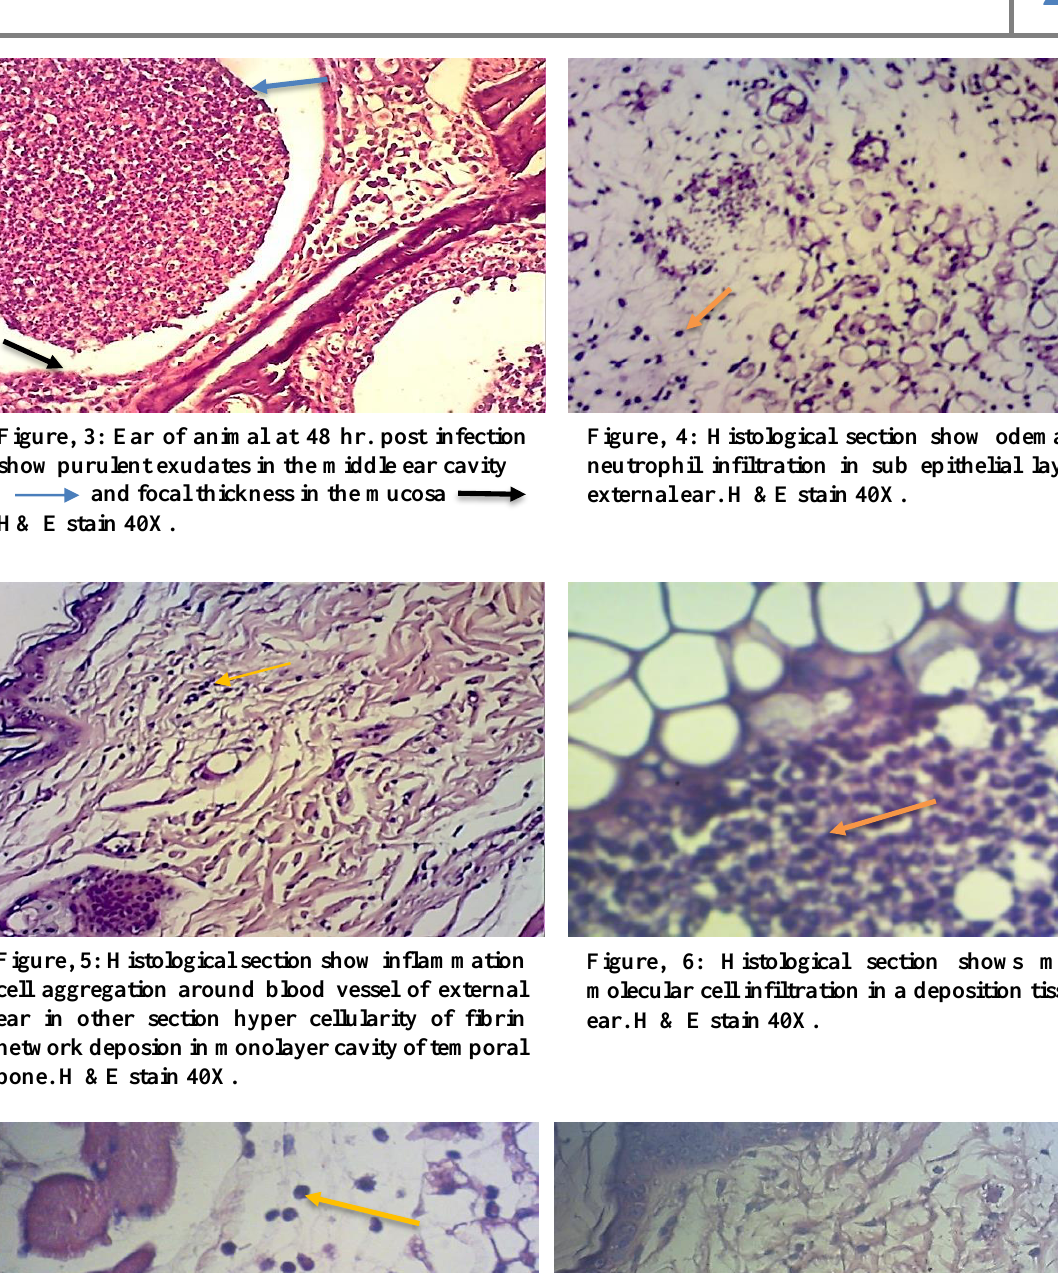
Figure, 8: Histological section of skin show inflammation cell around the hair floccules. H & E stain